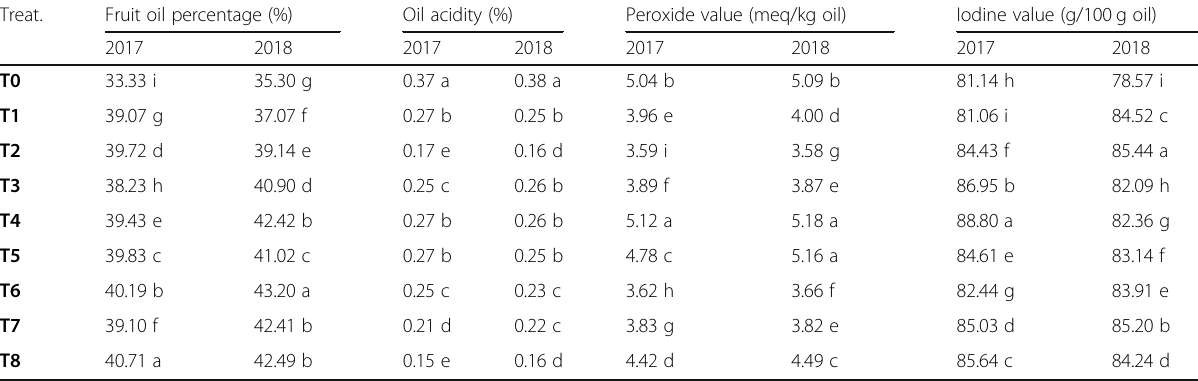
Table 7 Effect of foliar application of B 2 O 3 and ZnO nanoparticles on fruit oil traits of Picual cultivar in 2017 and 2018 seasons Treat. Fruit oil percentage